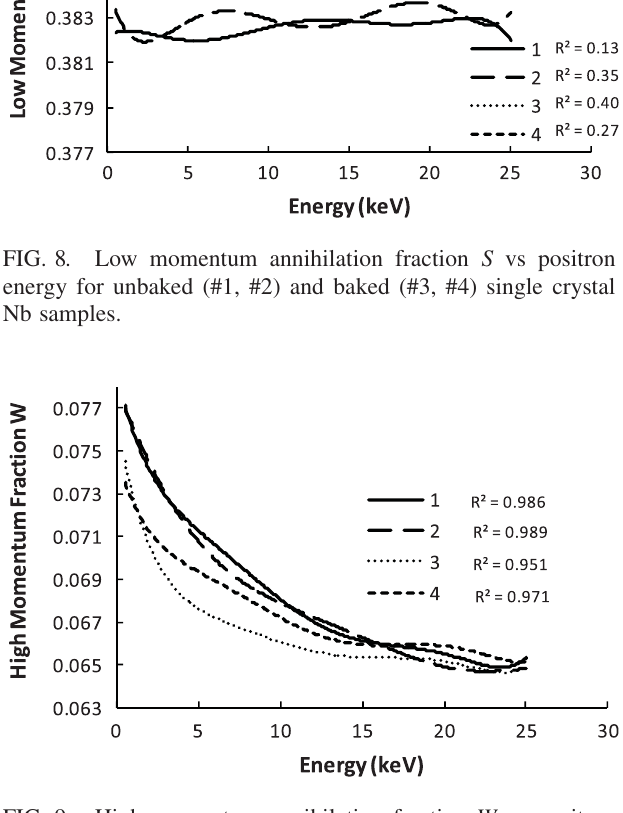
FIG. 10. S versus W plot for unbaked SC and FG samples (raw